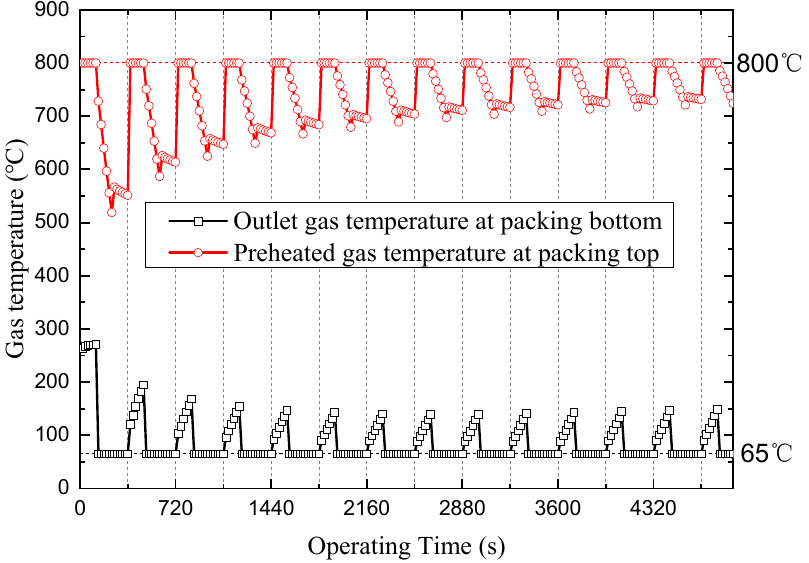
Figure 5. Temperature evolution of inlet and outlet gas temperatures.